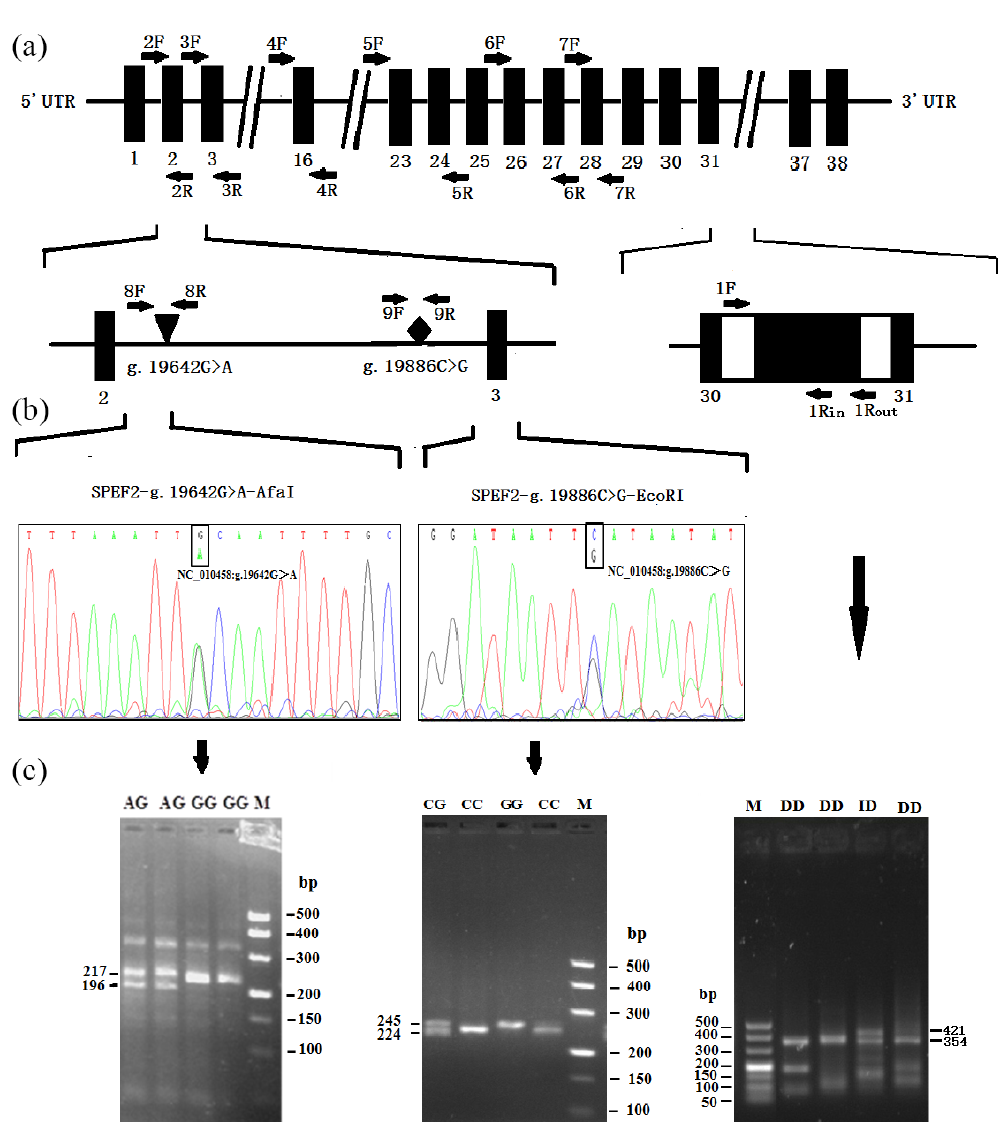
Figure 1. Structure mode, sequence chromas and electrophoresis pattern of the pig SPEF2 gene. (a) Position of primers on SPEF2 gene sequences, (b) sequence chromas of two novel SNP loci of the pig SPEF2 gene, and (c) electrophoresis pattern of two novel SNPs and an indel of the pig SPEF2